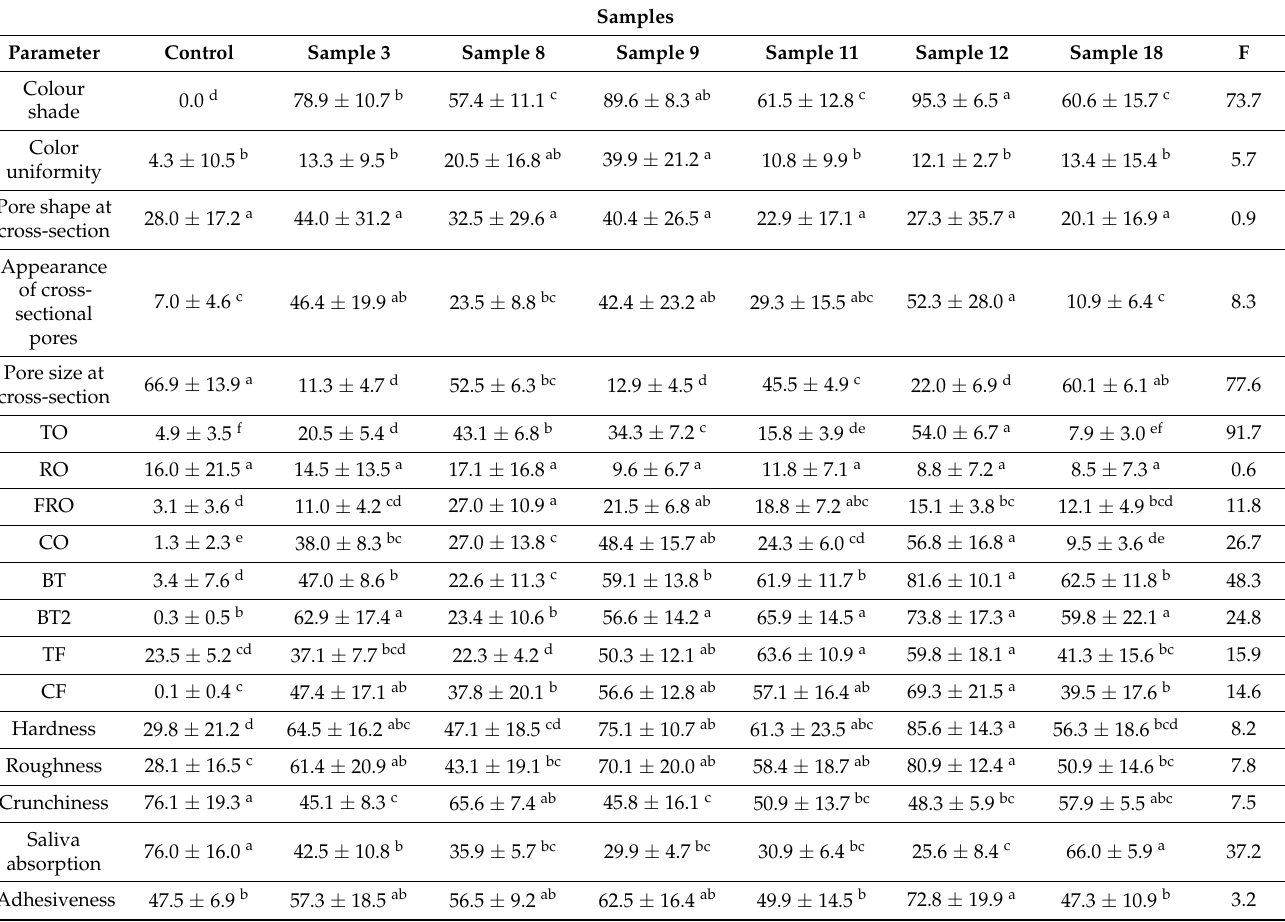
Table 4. Sensory analysis of extrudate